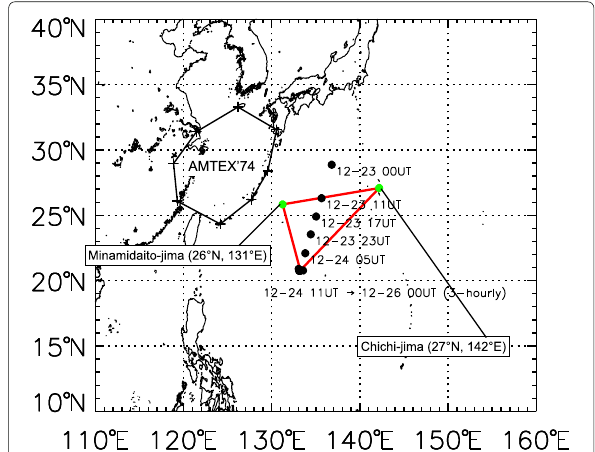
Fig. 1 The observation sites of the radiosondes used in this study. Black circles show the launch position of the radiosondes from the R/V Hakuho-maru. The radiosonde stations at Minamidaitojima and Chichijima are indicated by green circles. The AMTEX ‘74 observation area is shown by the black polygon